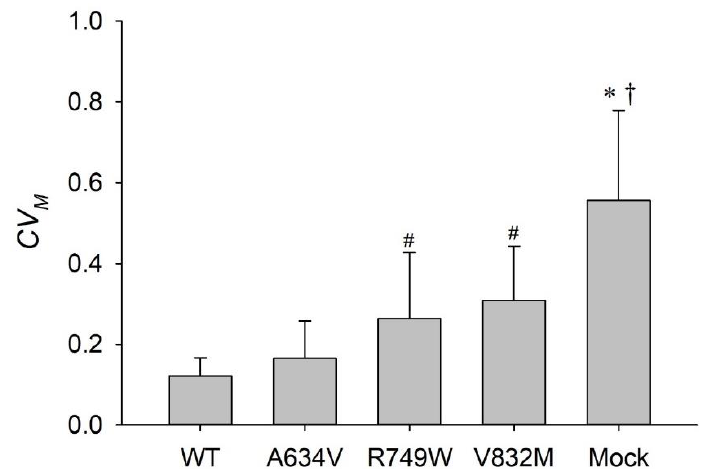
Figure 4. Impact of E-cadherin variants on tensional homeostasis. Median values of the coefficient of variation of the contractile moment ( CV M ) of WT, A634V, V832M, R749W, and Mock AGS cells cultured on the combination of Fibronectin and Vitronectin micropatterns. The Mock cells exhibit a significantly greater CV M than the WT, A634V, R749W (* p < 0.05), and V832M ( † p < 0.1), whereas the R749W and V832M exhibit a significantly greater CV M than the WT and A634V cells ( # p < 0.05). Graphs are median ± MAD.